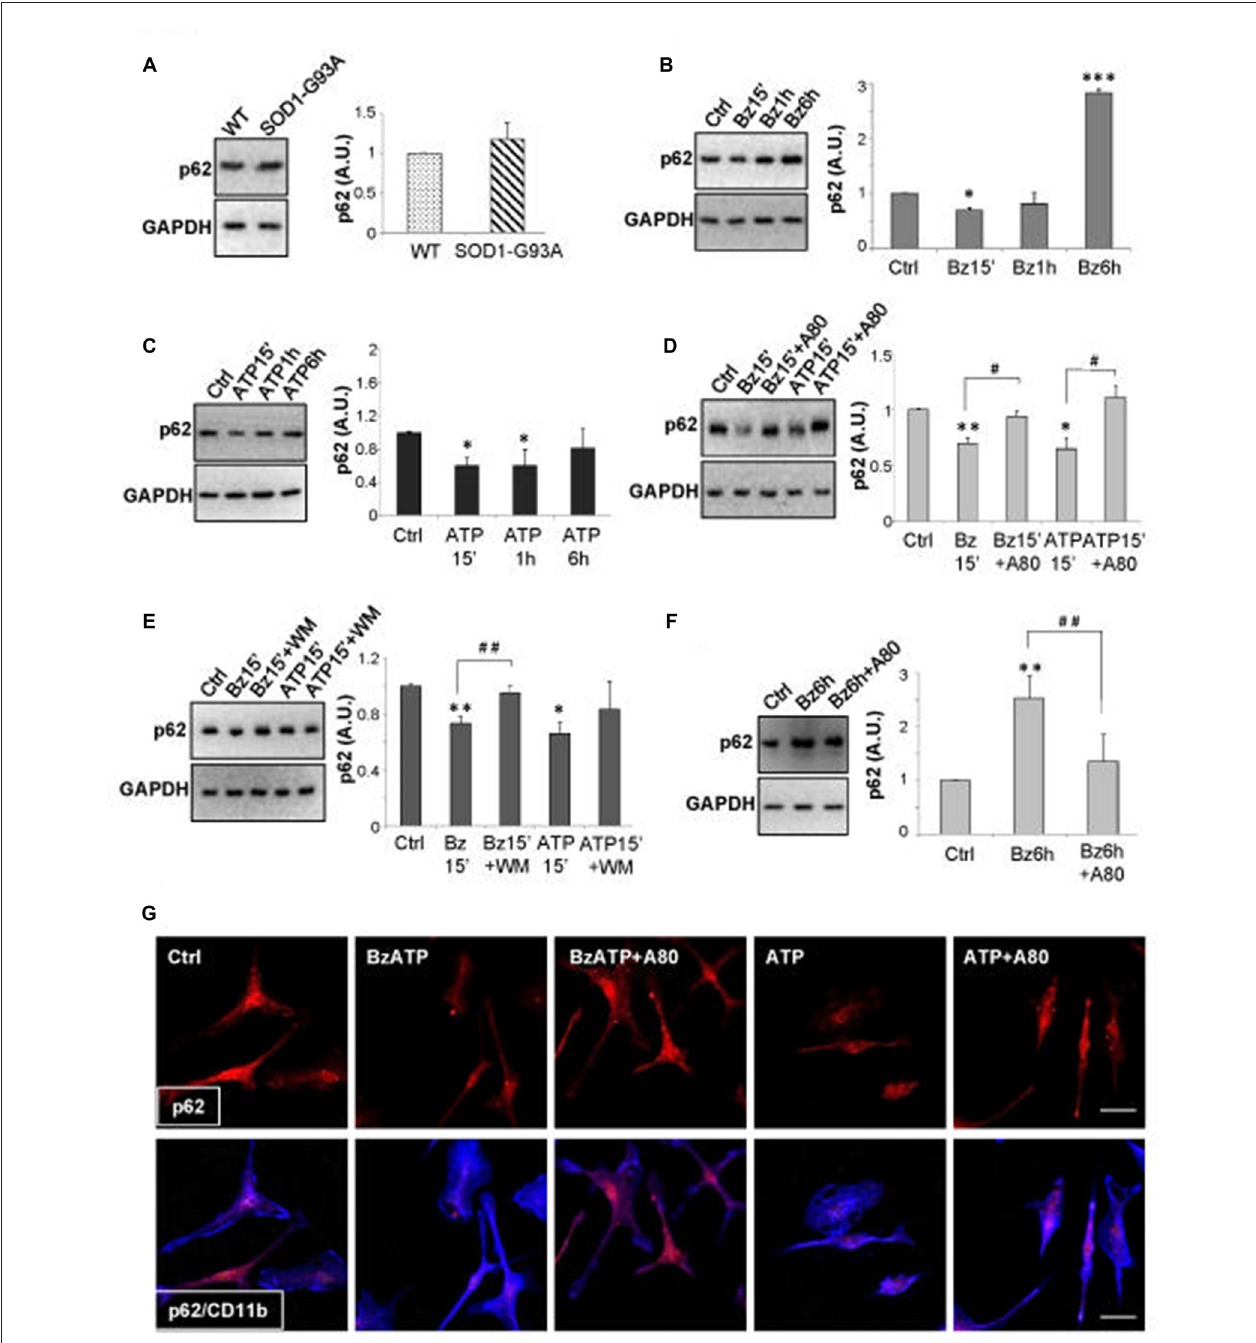
FIGURE 4 | Activation of P2X7 affects SQSTM1/p62 levels in SOD1-G93A microglia. (A) Equal amounts of protein from SOD1-G93A and WT microglia were subjected to western blotting and immunoreactions with anti-SQSTM1/p62 and anti-GAPDH. SOD1-G93A microglia were exposed to 300 µ M BzATP (B) or 3 mM ATP (C) for 15 min, 1 h or 6 h and equal amounts of total protein were subjected to western blotting and immunoreactions with anti-SQSTM1/p62 and anti-GAPDH. SOD1-G93A microglia were exposed to 300 µ M BzATP or 3 mM ATP for 15 min with or without A-804598 10 µ M (D) or WM 100 nM (E) and equal amounts of protein were subjected to western blotting and immunoreactions with anti-SQSTM1/p62 and anti-GAPDH. (F) SOD1-G93A microglia exposed to 300 µ M BzATP for 6 h with or without 10 µ M A-804598 were subjected to western blotting and immunoreactions with anti-SQSTM1/p62 and anti-GAPDH. (G) SOD1-G93A microglia treated for 15 min with 300 µ M BzATP or 3 mM ATP in the absence or presence of 10 µ M A-804598 were analyzed by means of fluorescence microscopy after staining with anti-SQSTM1/p62 (red) and CD11b (blue) (scale bar 50 µ m). Data represent mean ± SEM of n = 3 independent experiments. Statistical significance was calculated by student’s t -test or ANOVA followed by Post Hoc Tukey’s test referred to Ctrl ( ∗ p < 0.05, ∗∗ p < 0.01, ∗∗∗ p < 0.001); to BzATP15’-treated cells or ATP15’-treated cells ( D,E ; # p < 0.05, ## p < 0.01), or BzATP6h-treated cells ( F ; ## p < 0.01).